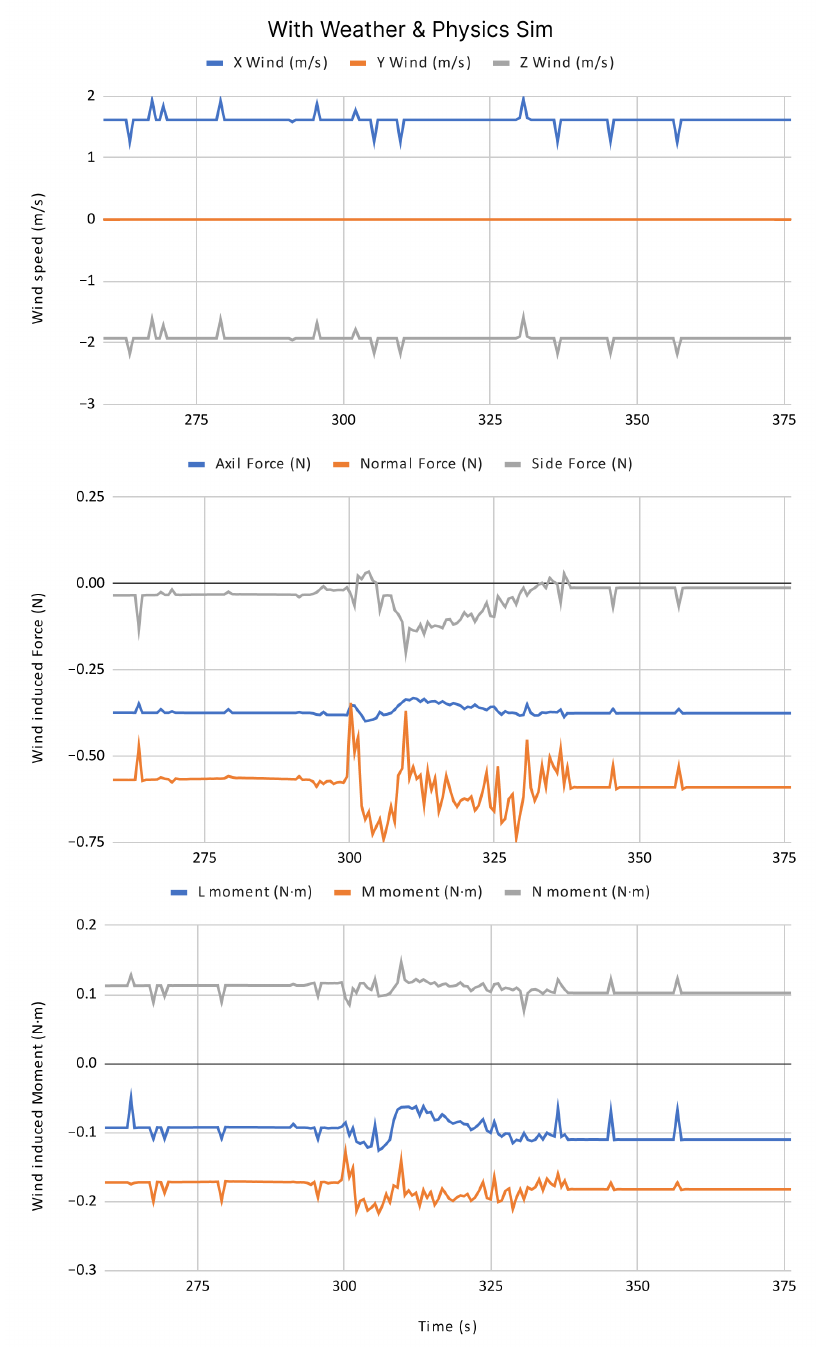
Figure 9. Forces and moments induced by wind using our custom weather and physics